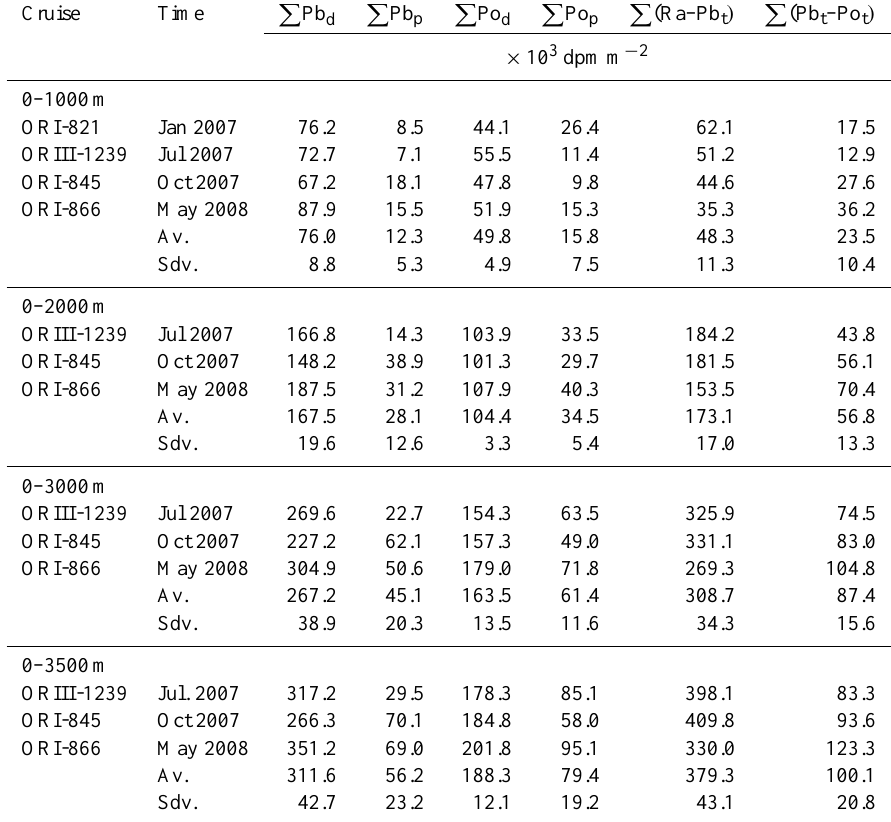
Table 2. Inventories of dissolved and particulate 210 Pb and 210 Po, deficiency of 210 Pb, and deficiency of 210 Po in the water column above four depth levels during the four cruises to the SEATS